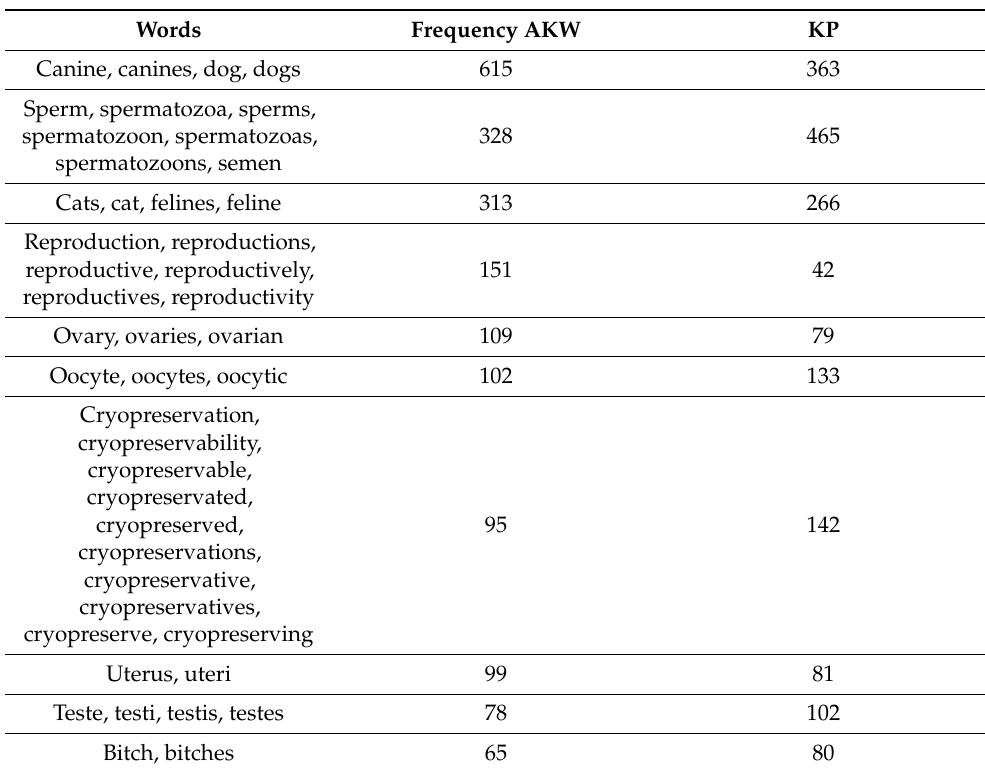
Table 4. Authors’ keywords (AKW) grouped according to controlled vocabulary (MeSH) and their frequencies. Frequencies of Keyword plus (KP) are also reported.